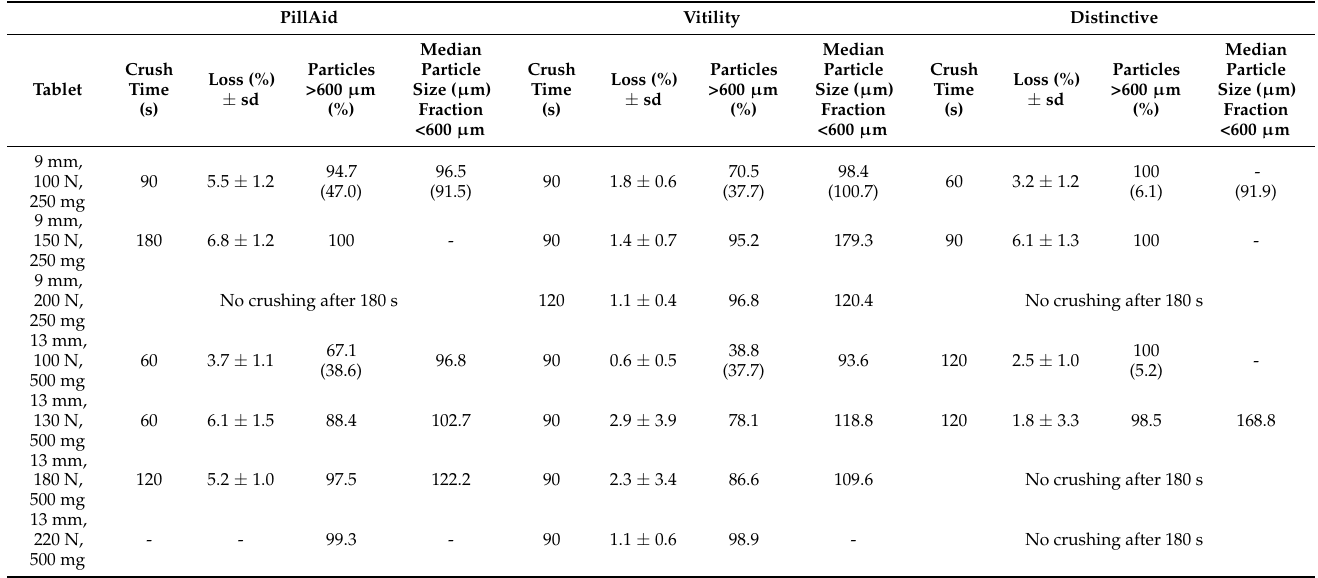
Table 3. Performance of screwcap crushers. Crush time (s) is the time needed to obtain a fine powder evaluated after 30, 60, 90, 120, and 180 s (six tablets, one by one). The percentage loss (mean ± sd, n = 6), the percentage particle >600 µ m of the pooled samples, and the median particle size of the pooled fraction <600 µ m are given after 1 min grinding and, for 100 N tablets only, after 2 min grinding (in brackets). Vitility